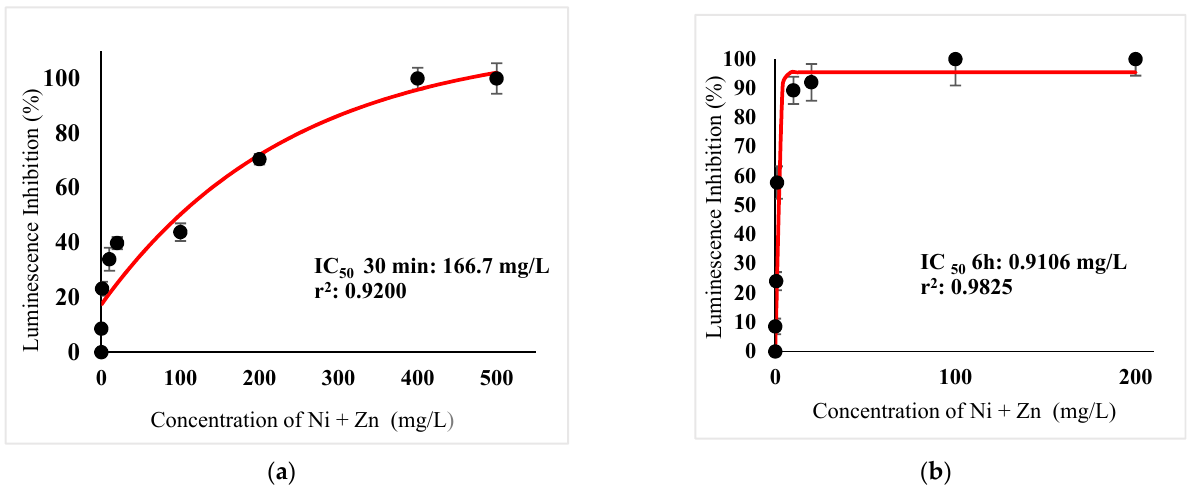
Figure 14. ( a ) Acute and ( b ) Chronic toxicity of mixture Ni 2+ + Zn 2+ in the concentration ratio of 1:1 on luminescence inhibition of Photobacterium sp.NAA-MIE. Data represent mean ± SD, n = 3.